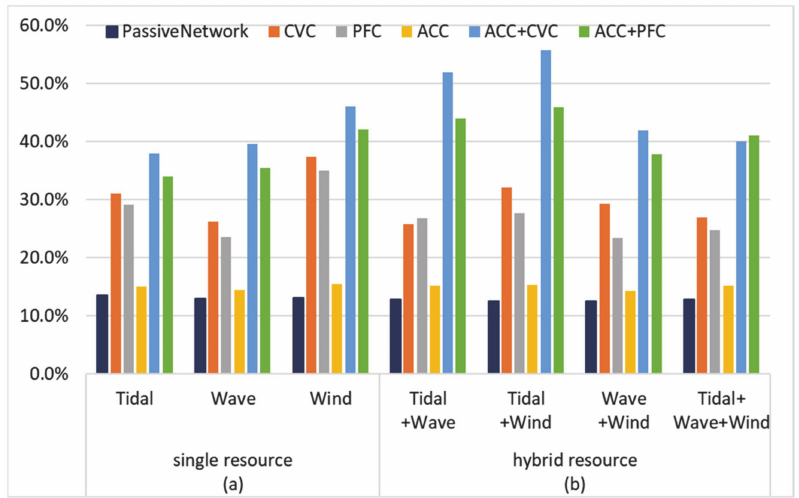
Figure 9. Average line loading in the whole year as percentage of its full value: ( a ) for single resource networks and ( b ) for hybrid resource